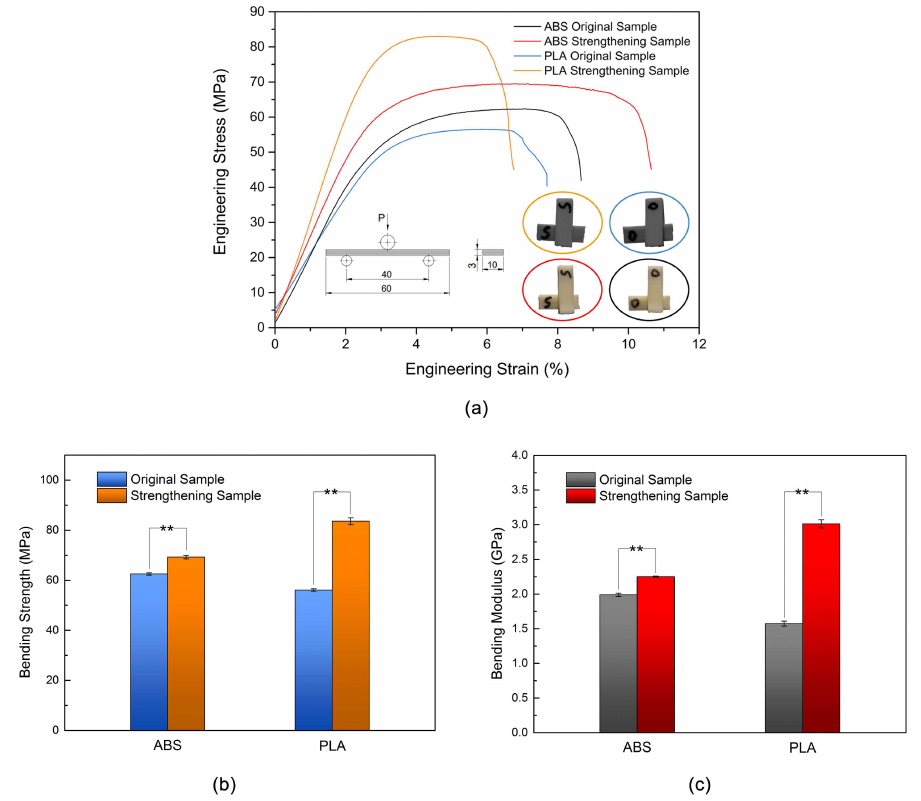
Figure 4. Bending stress–strain curves ( a ); bending strength ( b ); and bending modulus ( c ) of original and strengthening samples. Data presented as mean ± standard deviation, ** = p < 0.01.